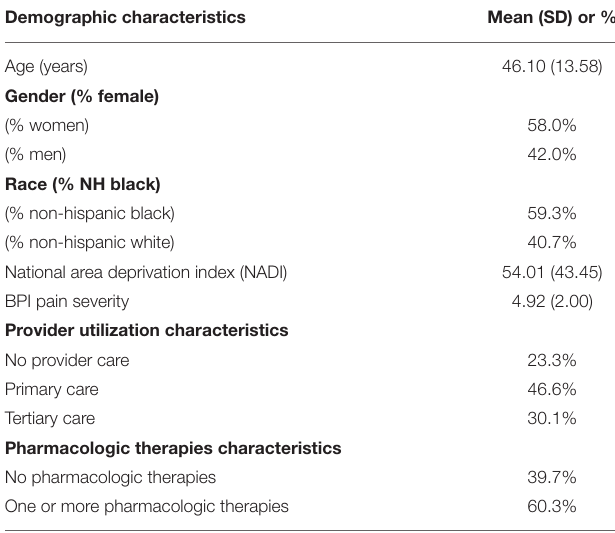
TABLE 1 | Descriptive characteristics, provider utilization, and use of pharmacologic therapies information for participants ( n = 174). Demographic characteristics